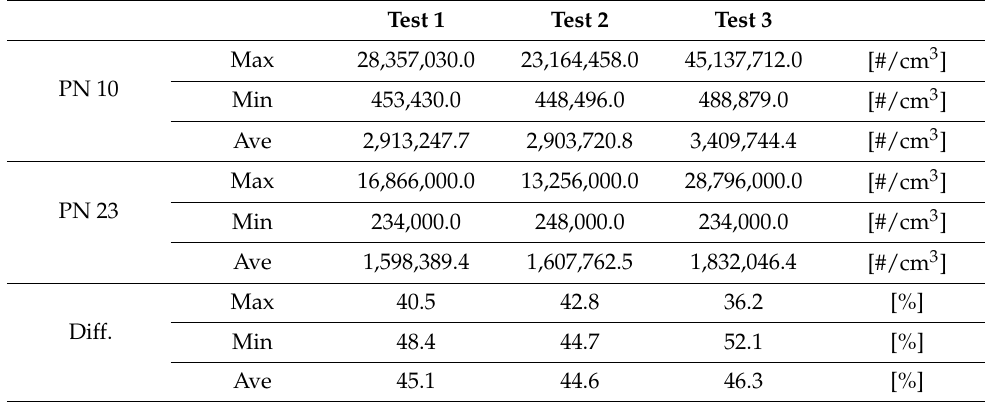
Table 1. Comparing particle count of the without DPF tests .